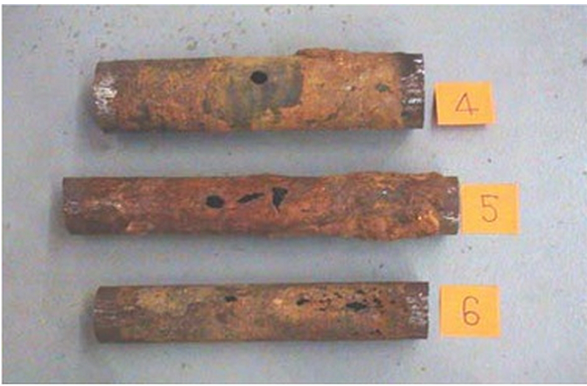
Figure 8. Corroded steel pipes (Greyvenstein and Van Zyl,